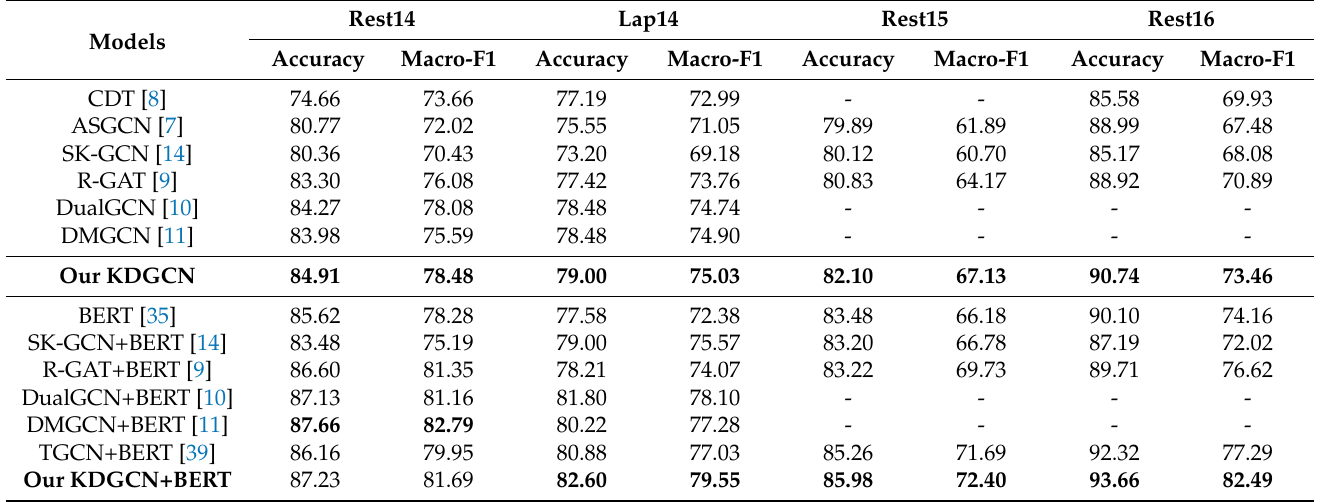
Table 2. Experimental results on four public datasets. The results of R-GAT and R-GAT+BERT are retrieved from [40], and others are retrieved from the original papers.